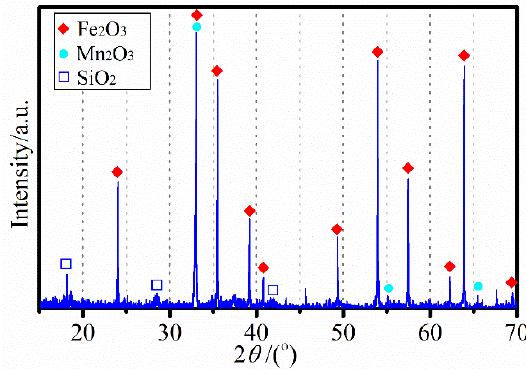
ff raction) pattern of the high-iron manganese ore used in the Figure 3. XRD (X-ray powder diffraction) pattern of the high-iron manganese ore used in the study. Figure 3. XRD (X-ray powder di